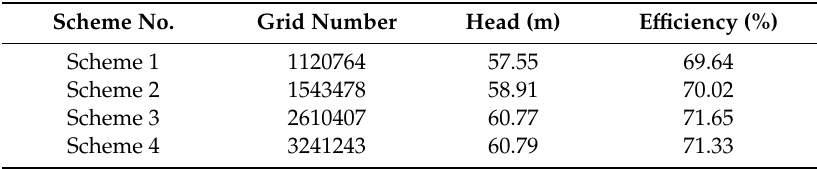
Table 2. Grid independence analysis.